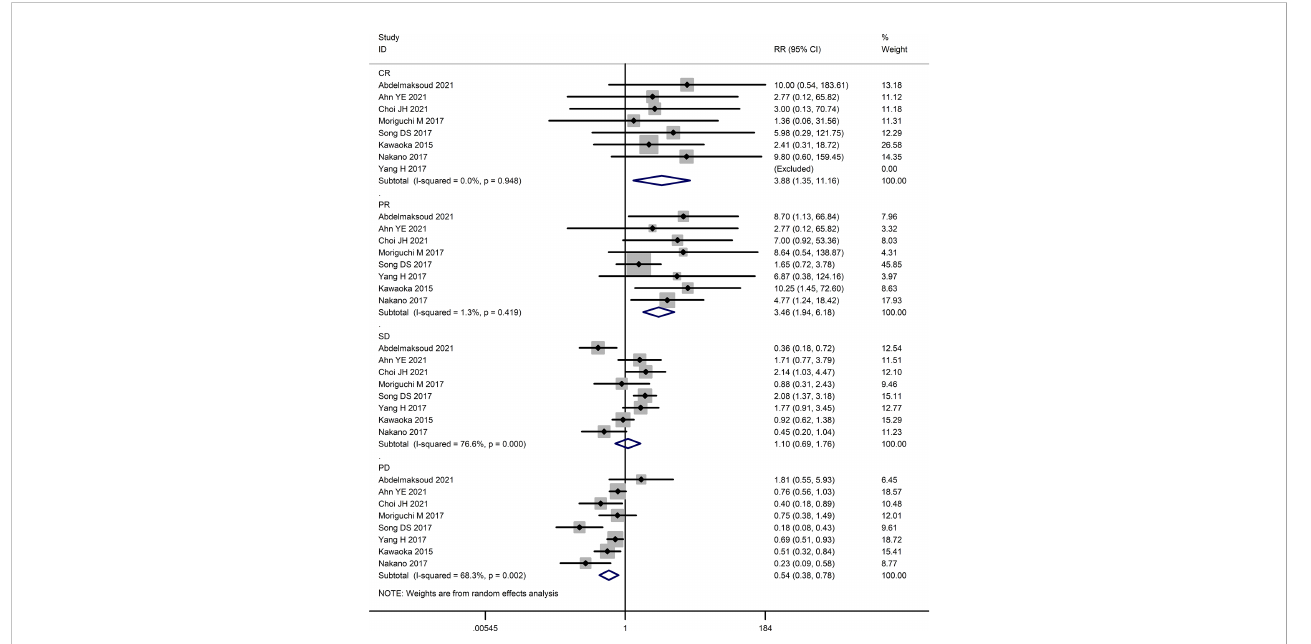
FIGURE 2 Forest map of complete response (CR) , partial response (PR) , stable disease (SD) , and progressive disease (PD)